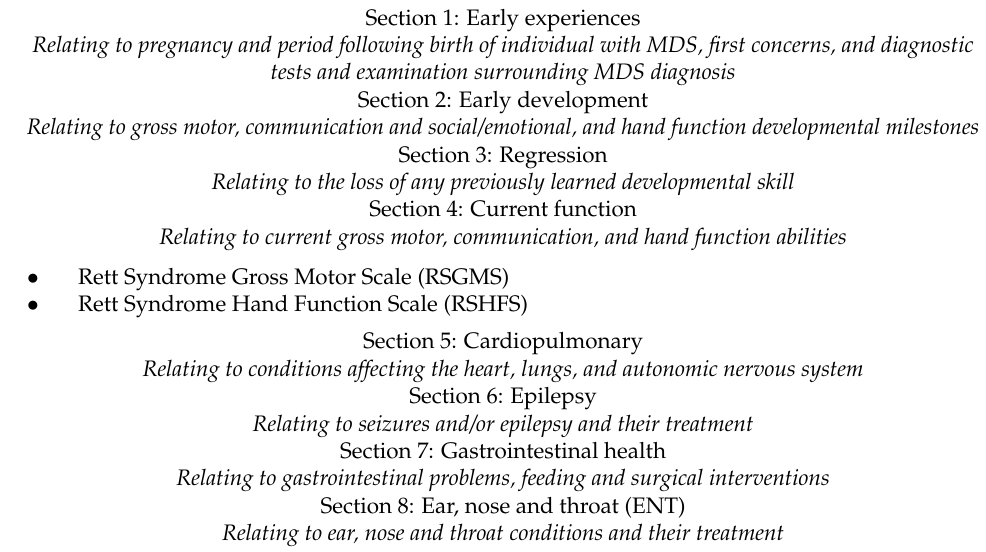
Table 1. Overview of the international MECP2 Duplication Database (MDBase) family questionnaire and associated